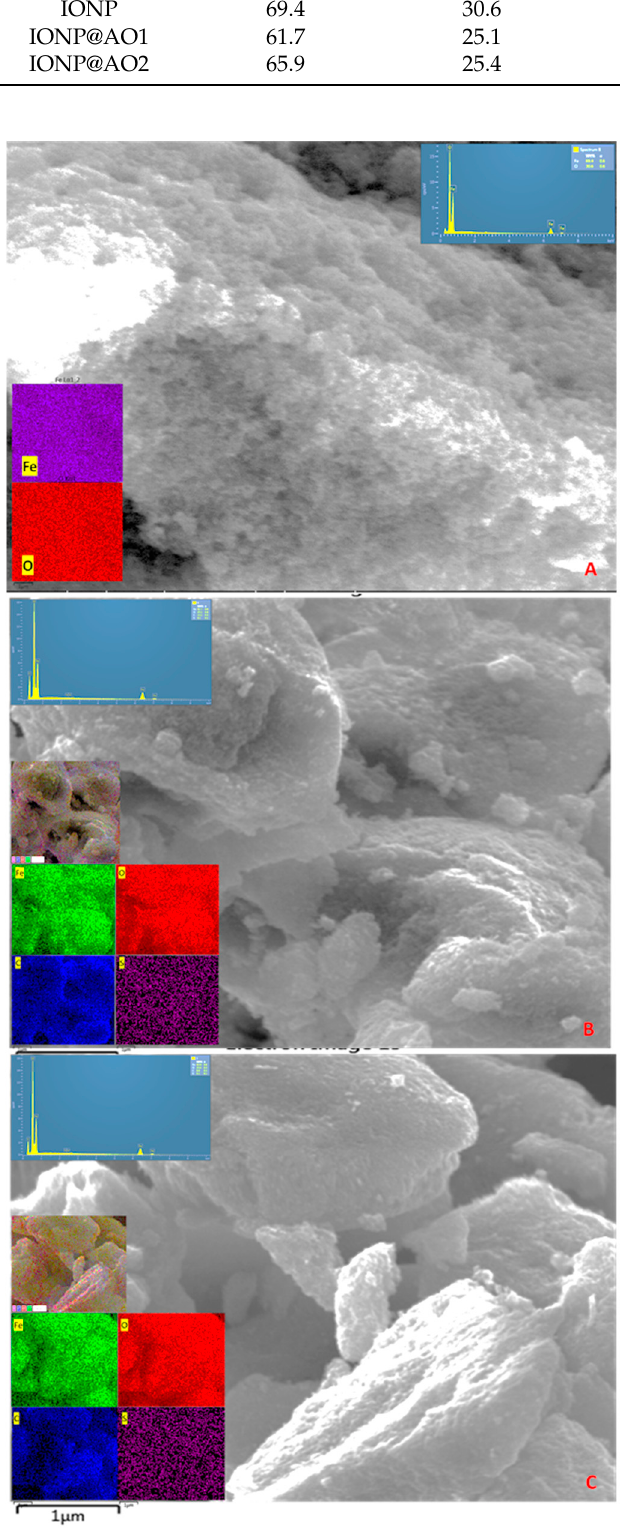
Figure 8. EDX of ( A ) IONP, ( B ) IONP@AO1, and ( C ) IONP@AO2.